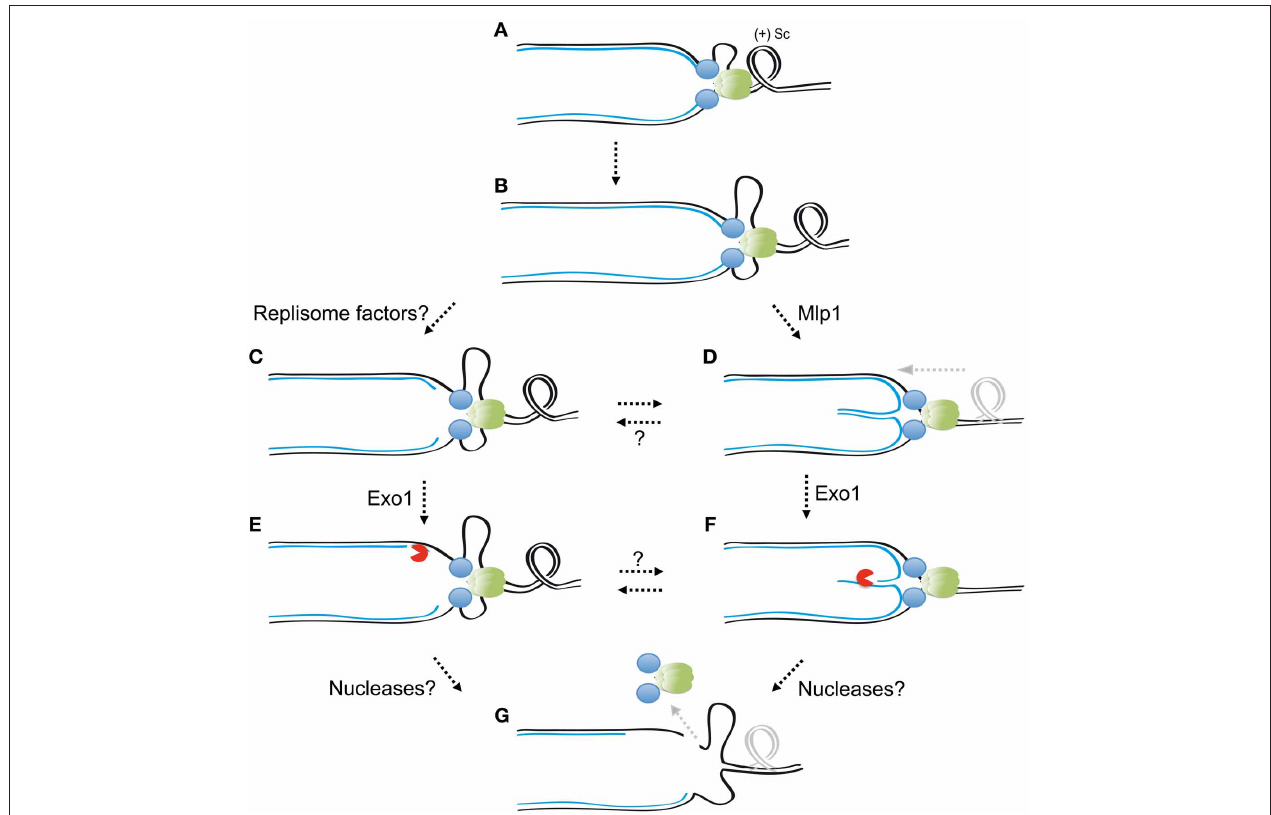
FIGURE 4 | Interplay between checkpoint-mediated mechanisms counteracting replication fork collapse. In unperturbed conditions replication fork advancement generates positive supercoiling (A) . Fork stalling and helicase/polymerases uncoupling generate extended ssDNA tracks triggering checkpoint activation (B) . Replisome factors targeting by checkpoint kinases might limit replisome tracking and thus prevent the dissociation of DNA polymerases from nascent strands termini (C) . Checkpoint kinases also inhibit Mlp1 function, allowing positive supercoiling diffusion, and counteracting replication fork reversal (D) . In the absence of